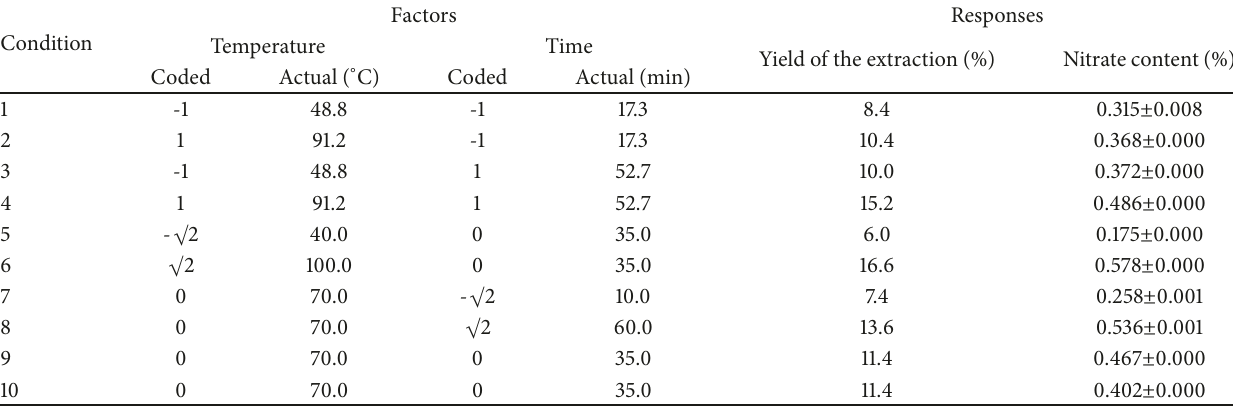
Table 1: Factors and responses of model conditions of circumscribed central composite experimental design. Factors Condition